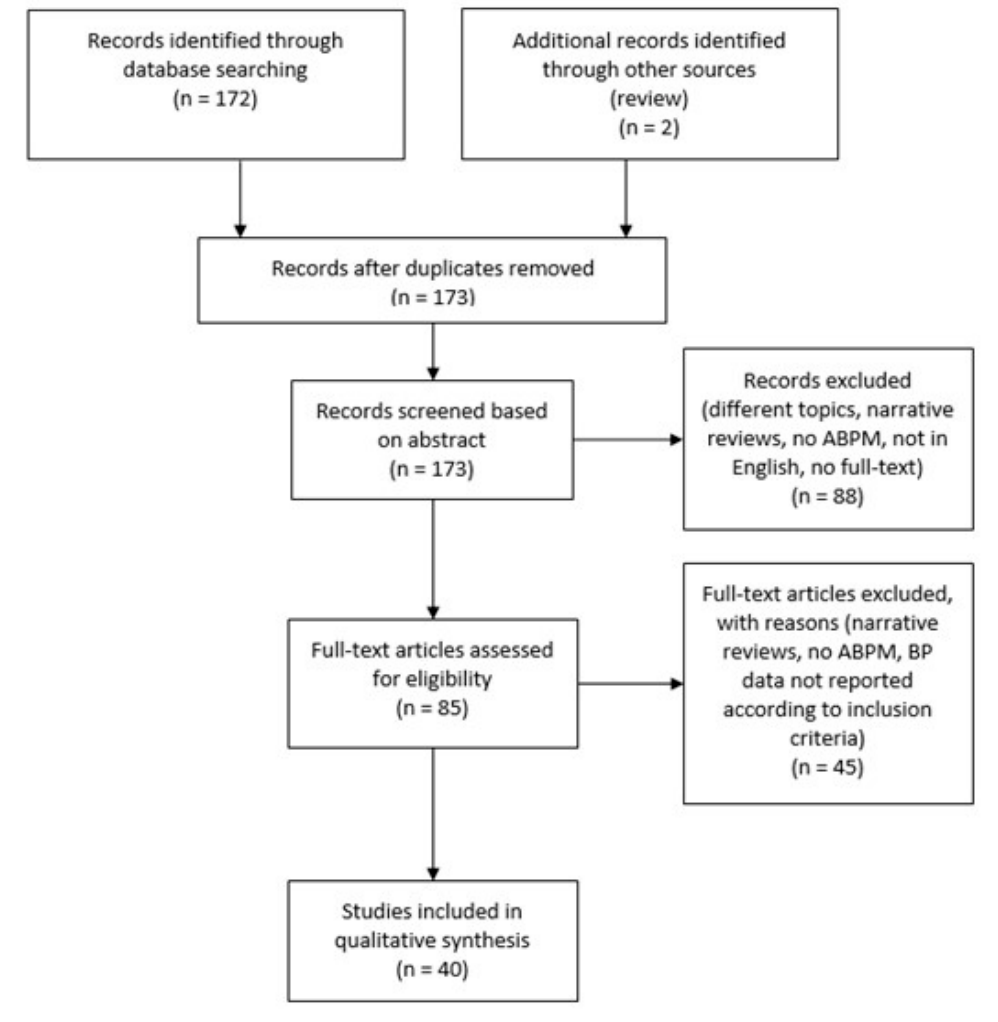
Figure 1. Flow diagram showing selection process.